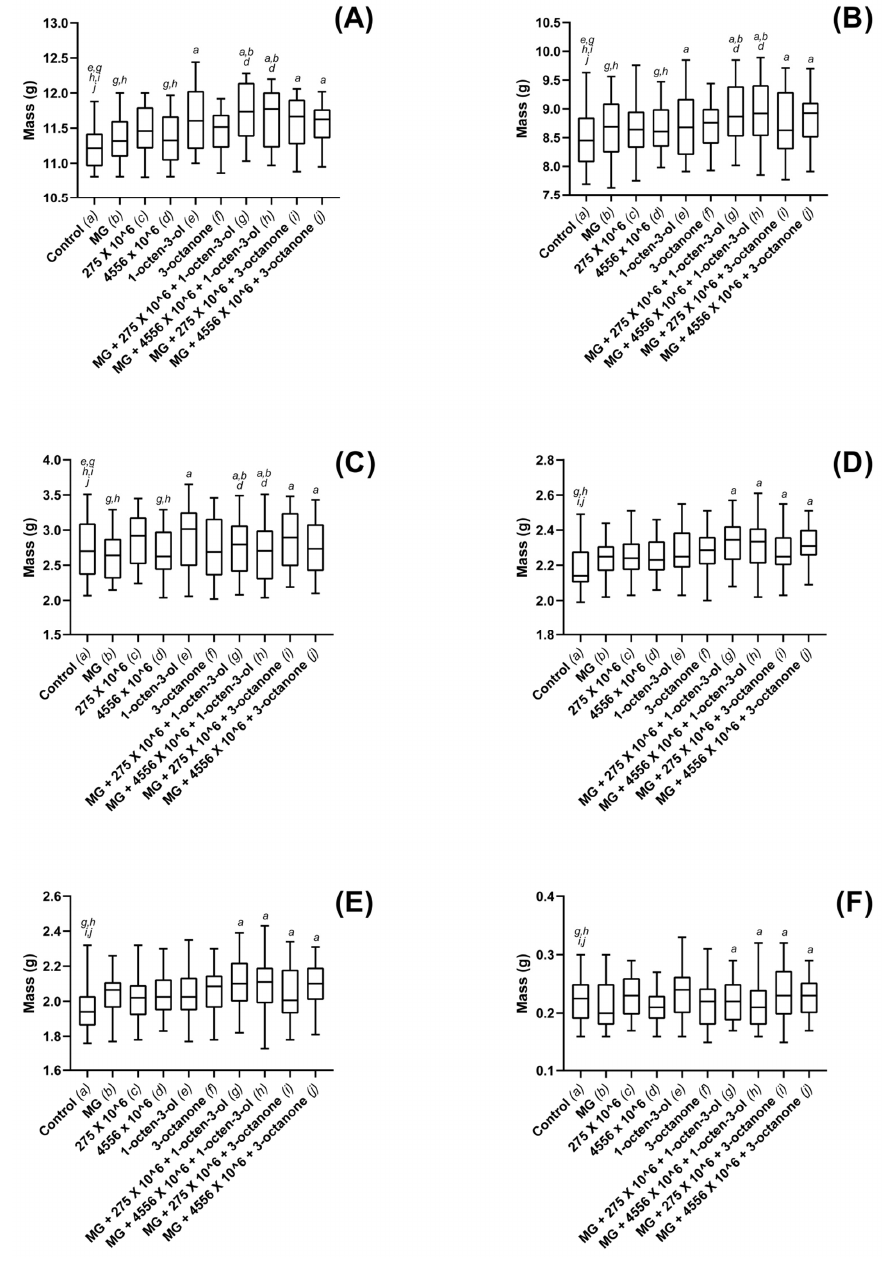
Figure 5. Plant growth metrics for maize plants exposed to M. brunneum , M. brunneum -derived VOCs and hydrogels. ( A ) whole-plant fresh mass, ( B ) whole-plant dry mass, ( C ) fresh shoot mass, ( D ) dry shoot mass ( E ) fresh root mass and ( F ) dry root mass, recordings for plants grown in composts treated with hydrogels (MG), M. brunneum strains: V275 or 4556, 1-octen-3-ol, 3-octanone or combinations thereof. All M. brunneum applications were standardized at 1 × 10 6 conidia g − 1 compost, and all VOCs were added at a rate of 1 µ L 100 g − 1 compost. Hydrogels were added according to manufacturer specification. Controls were grown in untreated composts. Plants were grown in a glasshouse maintained at 25 ± 2 ◦ C for a total of six weeks. Controls were exposed to compost media without additional treatment. Figure display’s minimum, 1st quartile, median, 3rd quartile and maximum measurements within the treatment groups. Significant results denoted between treatments using letters ( a – j ) above each boxplot; where denotation letters are absent, no significant differences were detected between treatments. Key: 275— M. brunneum (Strain: